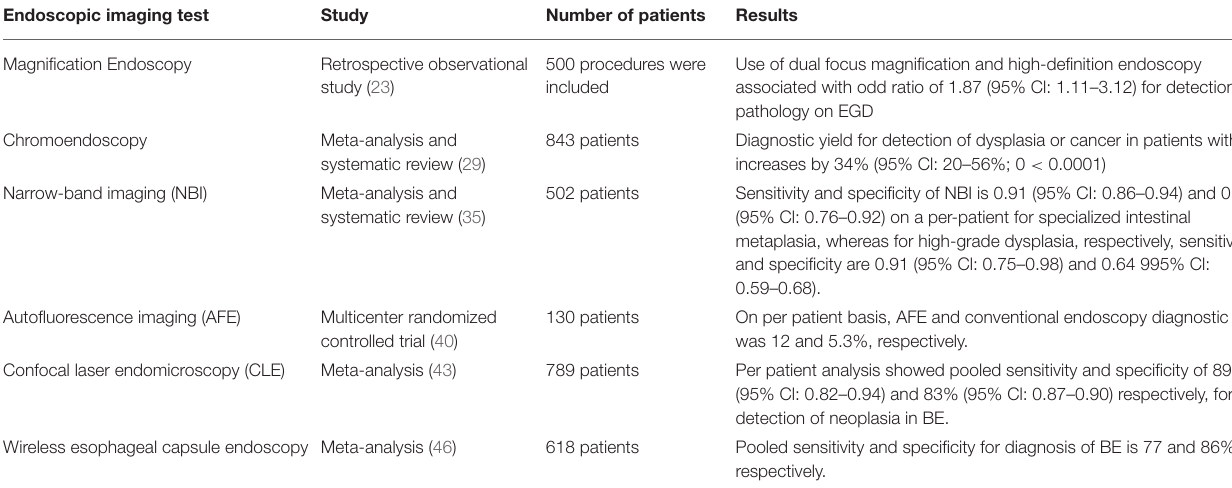
TABLE 1 | Endoscopic imaging for GERD